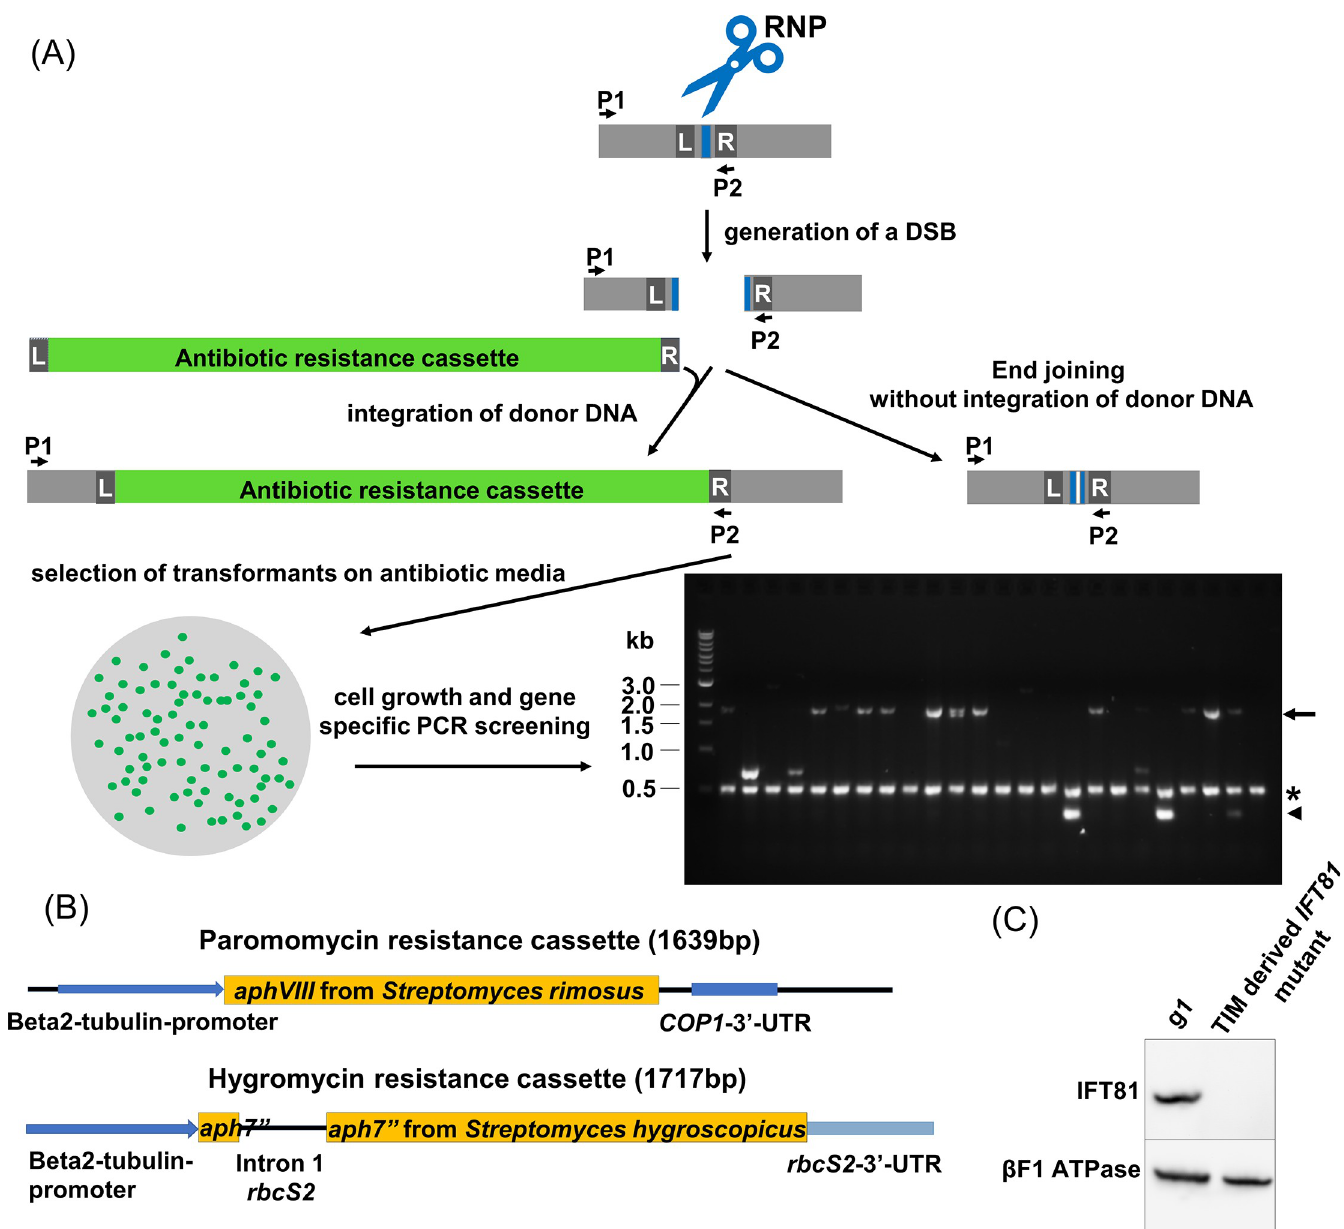
Fig 1. An overview of the TIM (targeted insertional mutagenesis) method. (A) Schematic overview of TIM. Following delivery of Cas9/gRNA RNP and double- stranded donor DNA (antibiotic-resistance cassette) into cells by electroporation or the glass-bead method, the RNP causes a double-stranded break (DSB) at the target site (blue box). DSBs are repaired with or without integration of the donor DNA. The left pathway results in insertional mutations, whereas the right pathway may generate insertion/deletion (indel) mutations (small white box within blue box, third row). As with other insertional mutagenesis approaches, donor DNA also can insert randomly in the genome, resulting in antibiotic-resistant cells that may not have a mutation at the target site. Cells are then selected for presence of the donor DNA via growth on antibiotic-specific media. Finally, antibiotic-resistant cells are screened via PCR to identify cell lines with mutations at the target site. L and R, left and right homology arms of the donor DNA, or genomic regions corresponding to left and right homology arms of the donor DNA. Short black arrows (P1, P2) indicate the primers used for screening. In the typical agarose gel shown (in this case, the targeted gene was FAP70 ), the asterisk and arrowhead on the right side of the gel indicate positive control (in this case FUS1 ) and wild-type target-specific PCR bands, respectively. Absence of a wild-type target-specific band indicates a mutation at the target site; in most cases here this is accompanied either by the appearance of an ~2-Kb band (arrow on the right side of the gel), suggesting insertion of a single copy of the antibiotic-resistance gene (~1.7 Kb), or by lack of any detectible gene-specific band, suggesting a large insertion/deletion at the target site. Presence of a wild-type target-specific band indicates that the cell line was not mutated at the target site; the antibiotic-resistance gene has inserted into the genome somewhere other than at the target site. Mutants generated by the right-hand pathway (no insertion of donor DNA) would not be selected for unless the donor DNA inserted into another site; in the latter case, mutants with small indels would appear to be wild type in the PCR screen because the PCR product would be at or near wild-type length. Relative to the